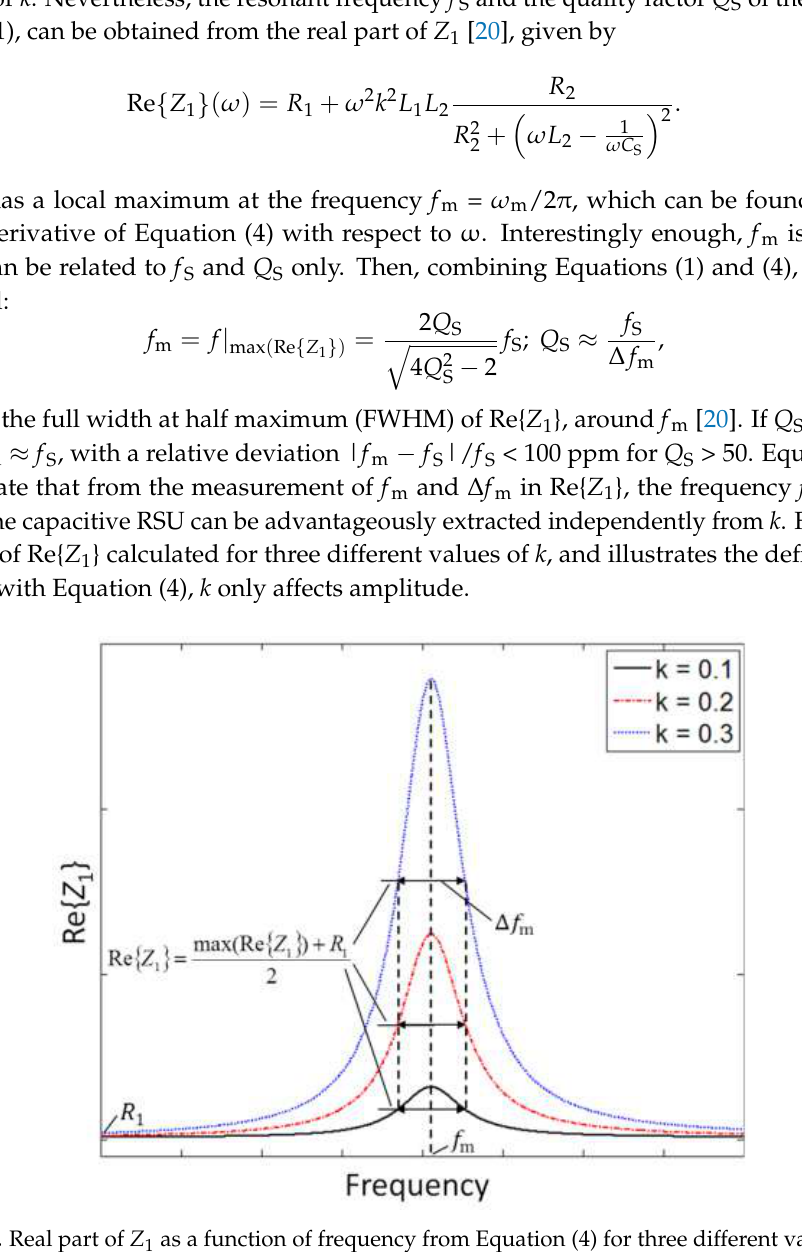
( b ) Figure 3. ( a ) Block diagram of the interrogation system based on impedance measurement from the primary coil; ( b ) equivalent circuit for the calculation of Z 1 .